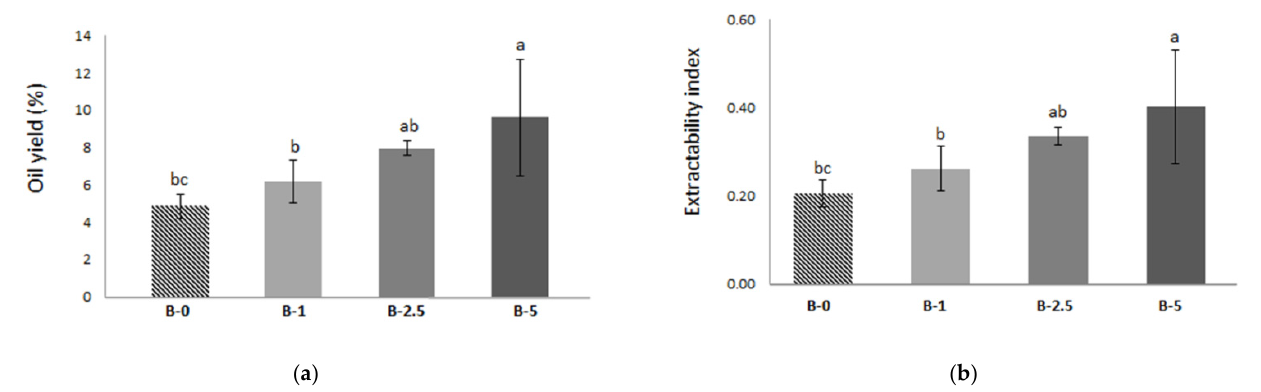
Figure 1. ( a ) Oil yield (%) and ( b ) extractability index determined in the production of Buža olive cultivar oil obtained without (B-0) and with the addition of different amounts of olive leaf: 1% (B-1), 2.5% (B-2.5) and 5% (B-5). Results are presented as mean values of three technical repetitions ± standard deviations. Different letters above bars represent significant differences among the treatments (Tukey’s test, p < 0.05) for each parameter separately.